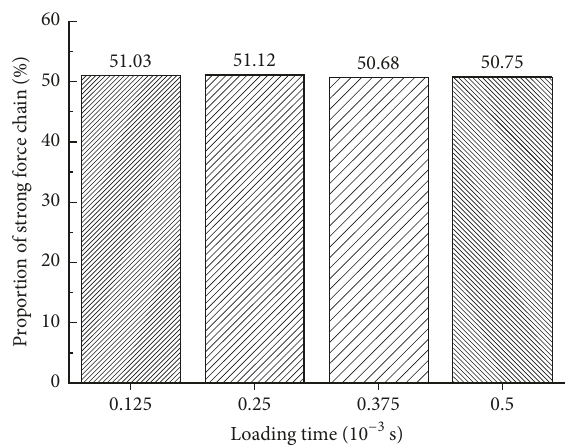
Figure 6: Proportion of strong force chain at four loading